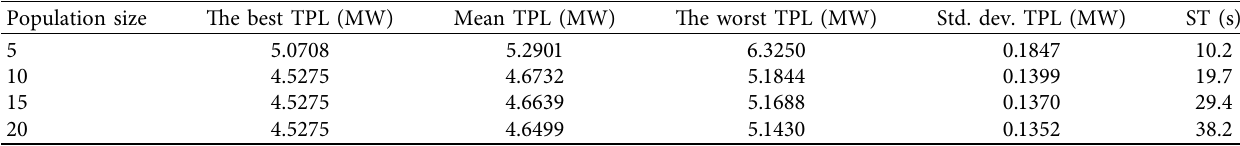
� 200 and WF � 1.0. pop , and fixing MI